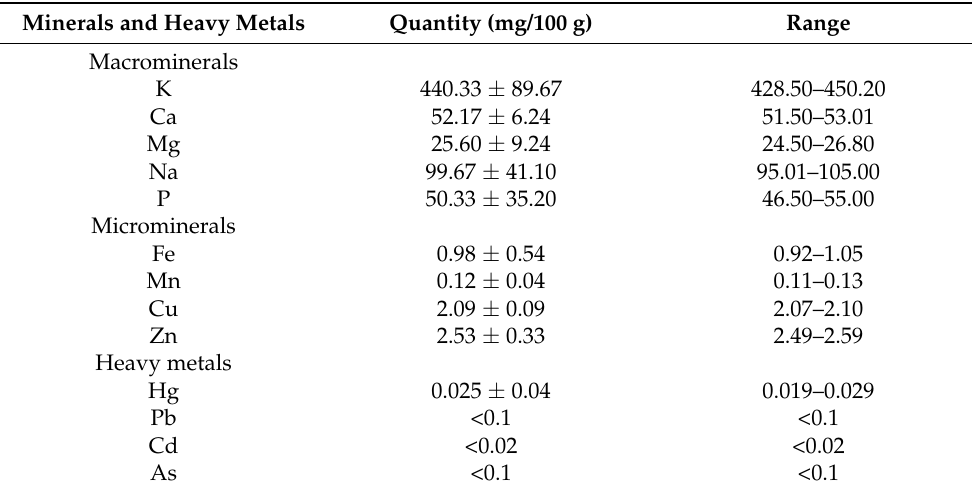
Table 4. Minerals and heavy metals contents of spiny-cheek crayfish